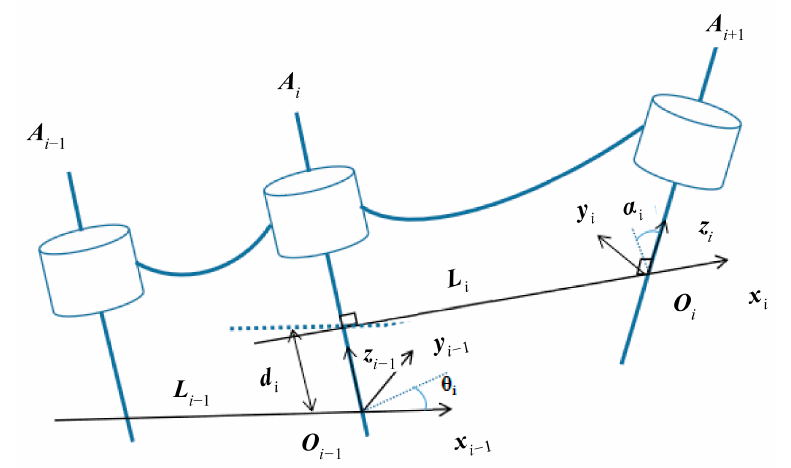
Figure 3. Connecting rod coordinate